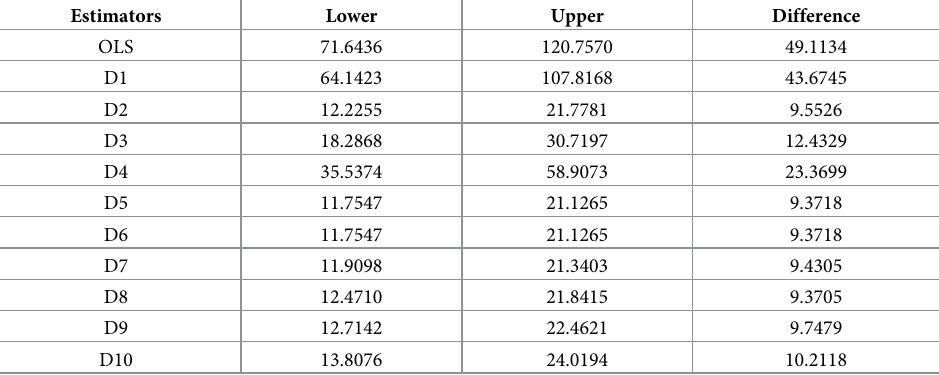
Table 8. 95% mean prediction interval for the Tobacco data.